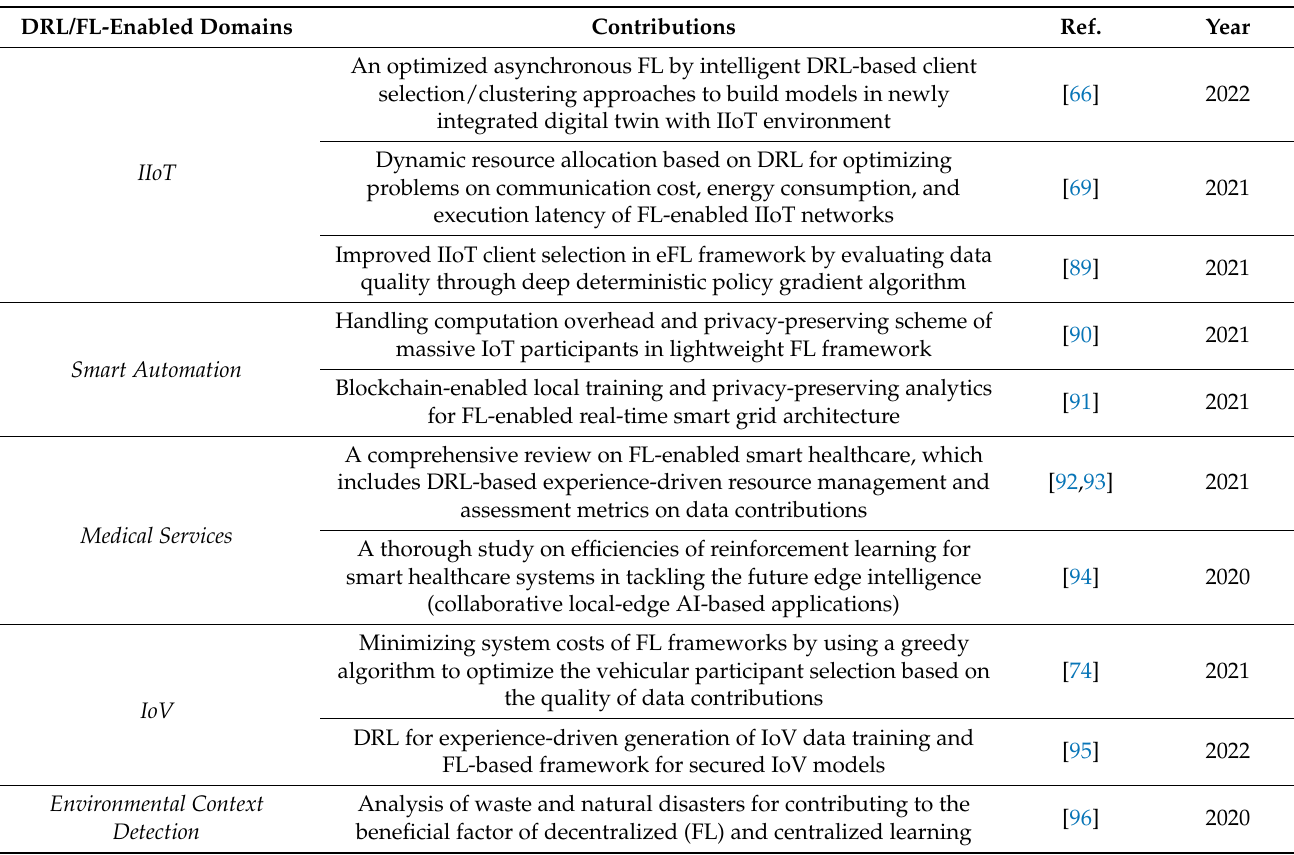
Table 5. Summary of Selected Works in Section 5, including DRL/FL-enabled Domains and